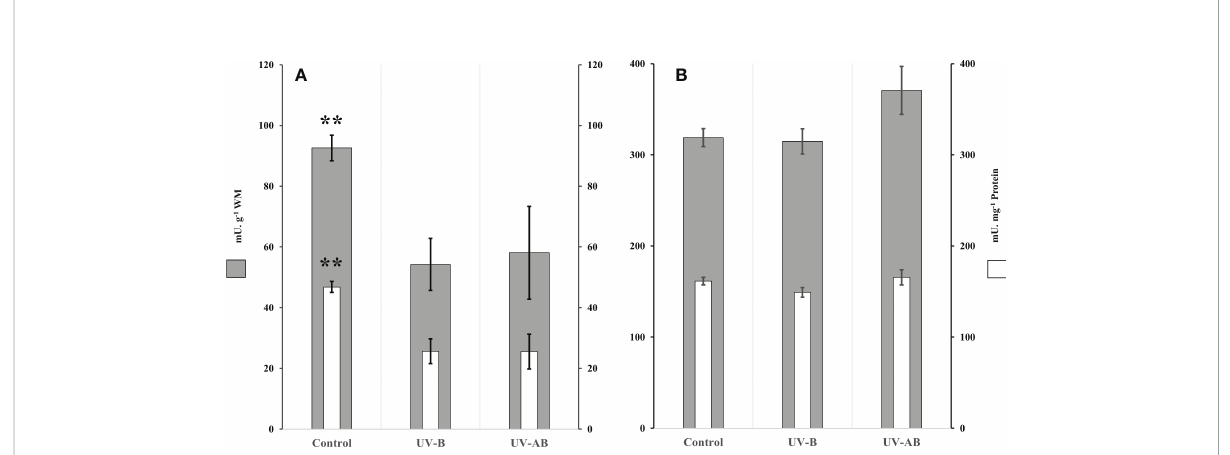
FIGURE 3 Glycolytic enzymes activity in Cassiopea oral arms in response to UVR. (A) Pyruvate kinase activity (PK); N = 8 (control), 6 (UV-B), and 6 (UV-AB). (B) Lactate dehydrogenase (LDH) activity; N = 8 (control), 5 (UV-B), and 6 (UV-AB). Data represent the mean ±SE; an asterisk above bars means statistical signi fi cance ( ∗ p ≤ 0.05 , ∗∗ p ≤ 0.01 ). Statistical signi fi cance was tested using Dunn (1964) Kruskal – Wallis multiple comparison test. Bars present the data in two normalization methods: 1- activity per wet body mass (i.e., external bars), 2- activity per total protein content (internal bars).